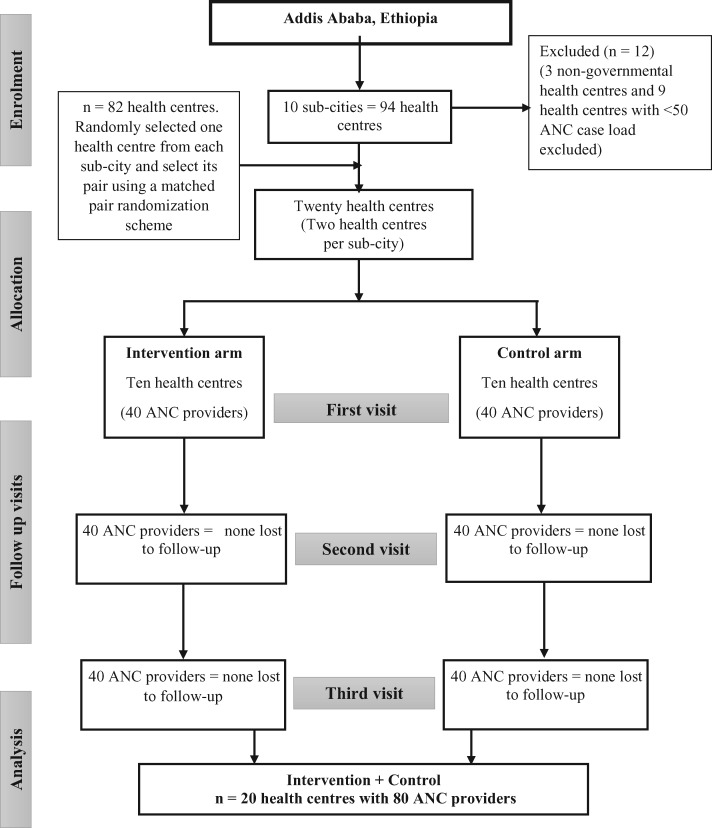
Flow diagram of the cluster health centres' and individual participant's enrolment, allocation and analysis. ANC, antenatal care